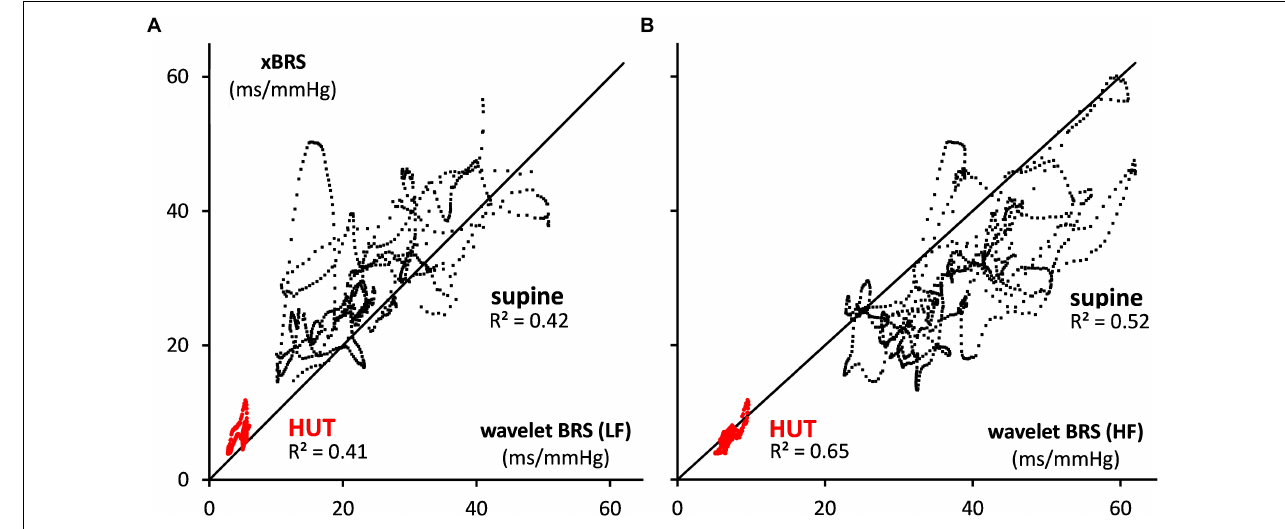
FIGURE 5 | Scatterplots of xBRS vs. the wavelet BRS in the (A) LF and (B) HF range. The black dots indicate data points in supine position, and red dots are for HUT. The black line of identity is shown.